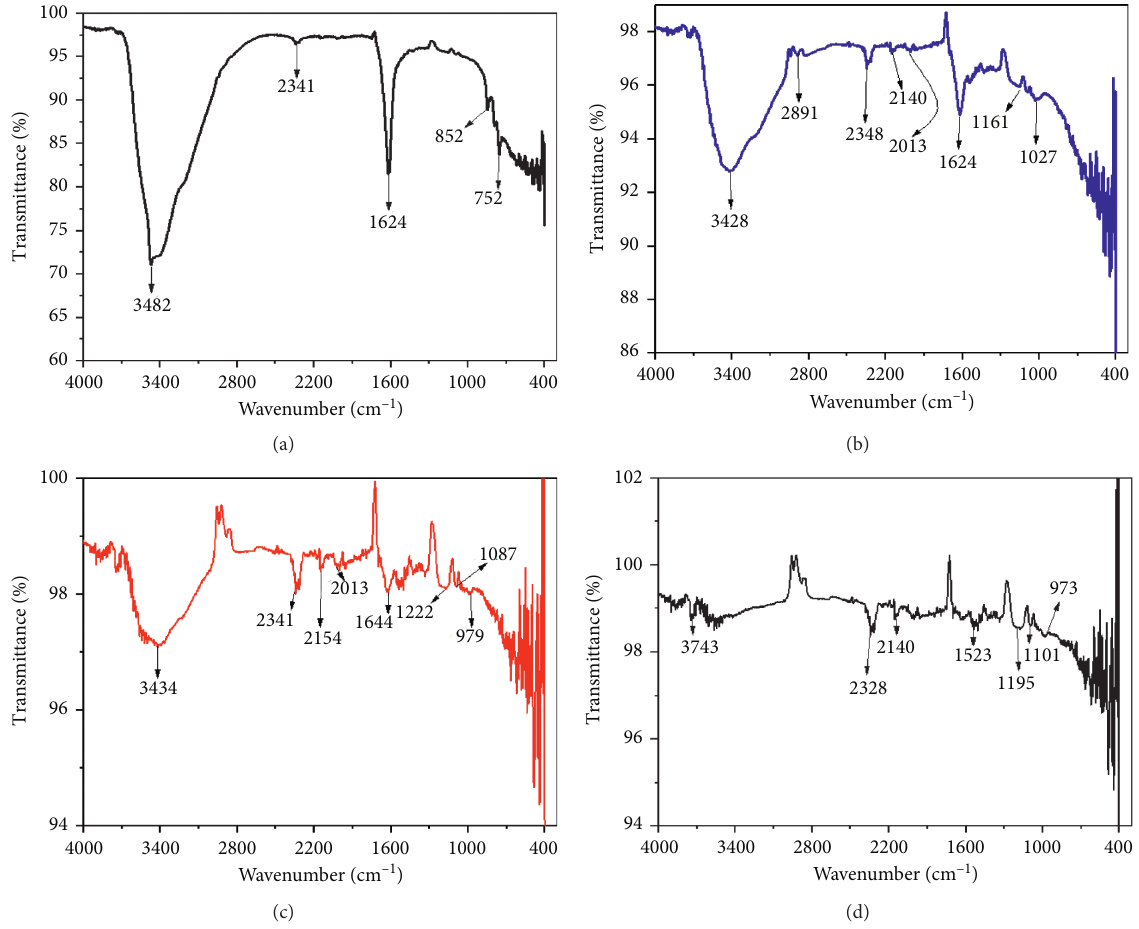
Figure 1: FTIR spectrum of sulfonated carbon catalysts (a) BC